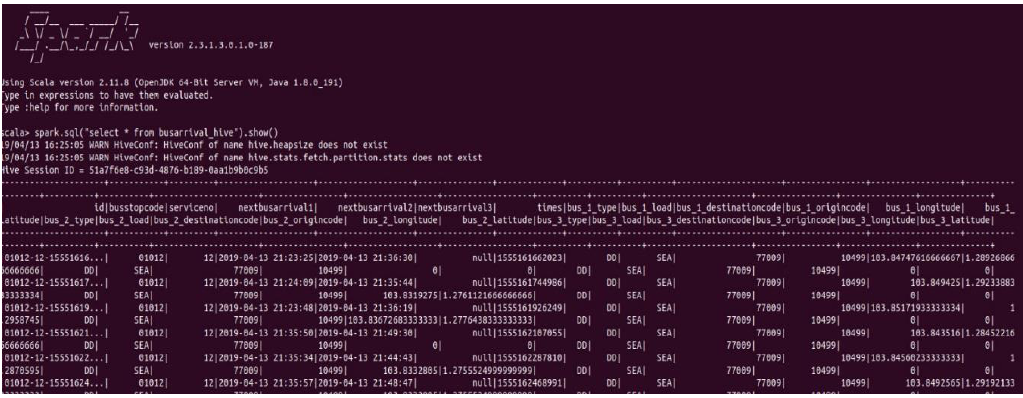
Figure 10. Results of a sample query of bus arrival data using Spark SQL.